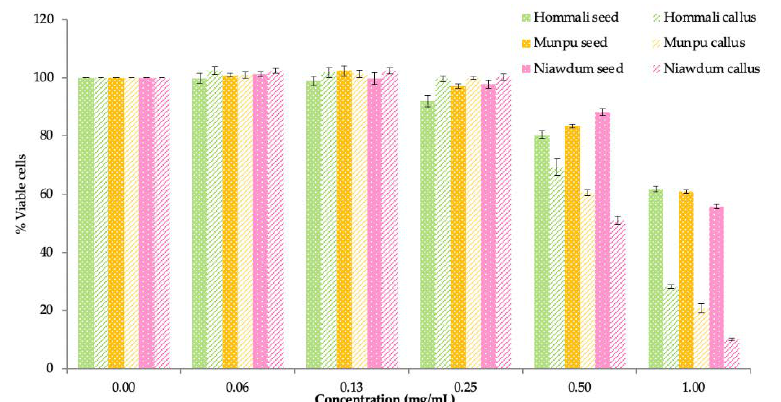
Figure 4. Cytotoxicity of the rice callus and seed extracts.